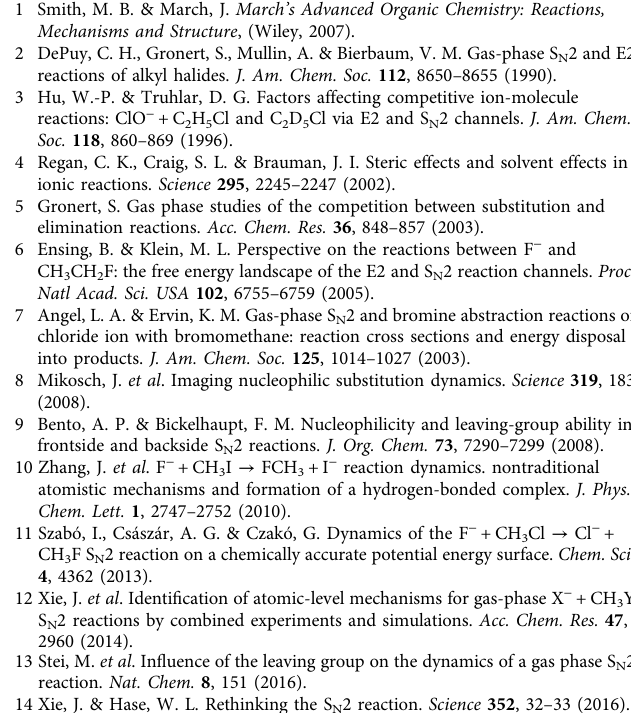
respectively, in good agreement with the experimental values of − 48.7 and − 37.6 kcalmol − 146 . To compare with the experiments, the simulations were performed at a collision energy of 1.9 eV and C 2 H 5 I rotational and vibrational temperatures of 165 and 250 K, respectively. Quasi-classical sampling, which includes ZPE, was